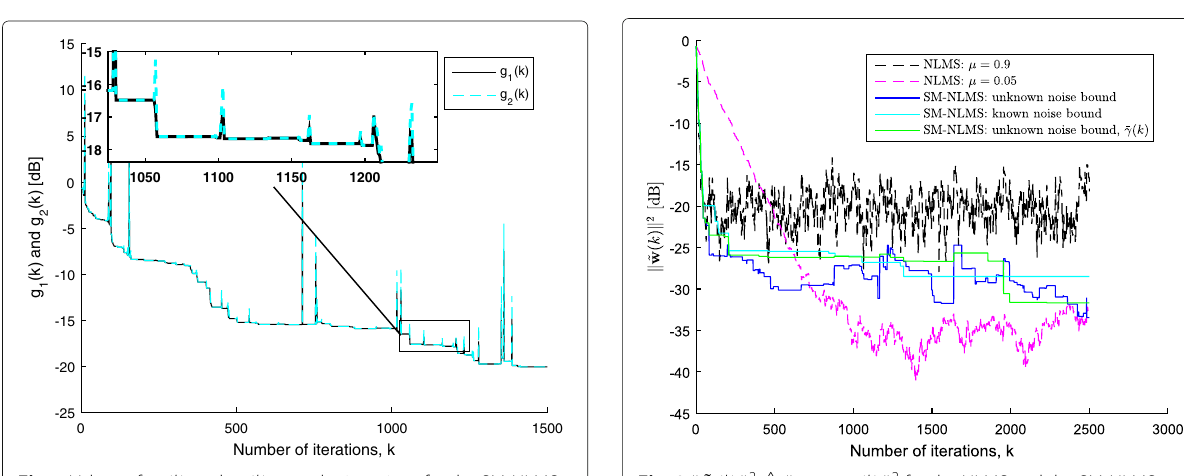
Fig. 1 Values of g 1 ( k ) and g 2 ( k ) over the iterations for the SM-NLMS algorithm corroborating Theorem 1